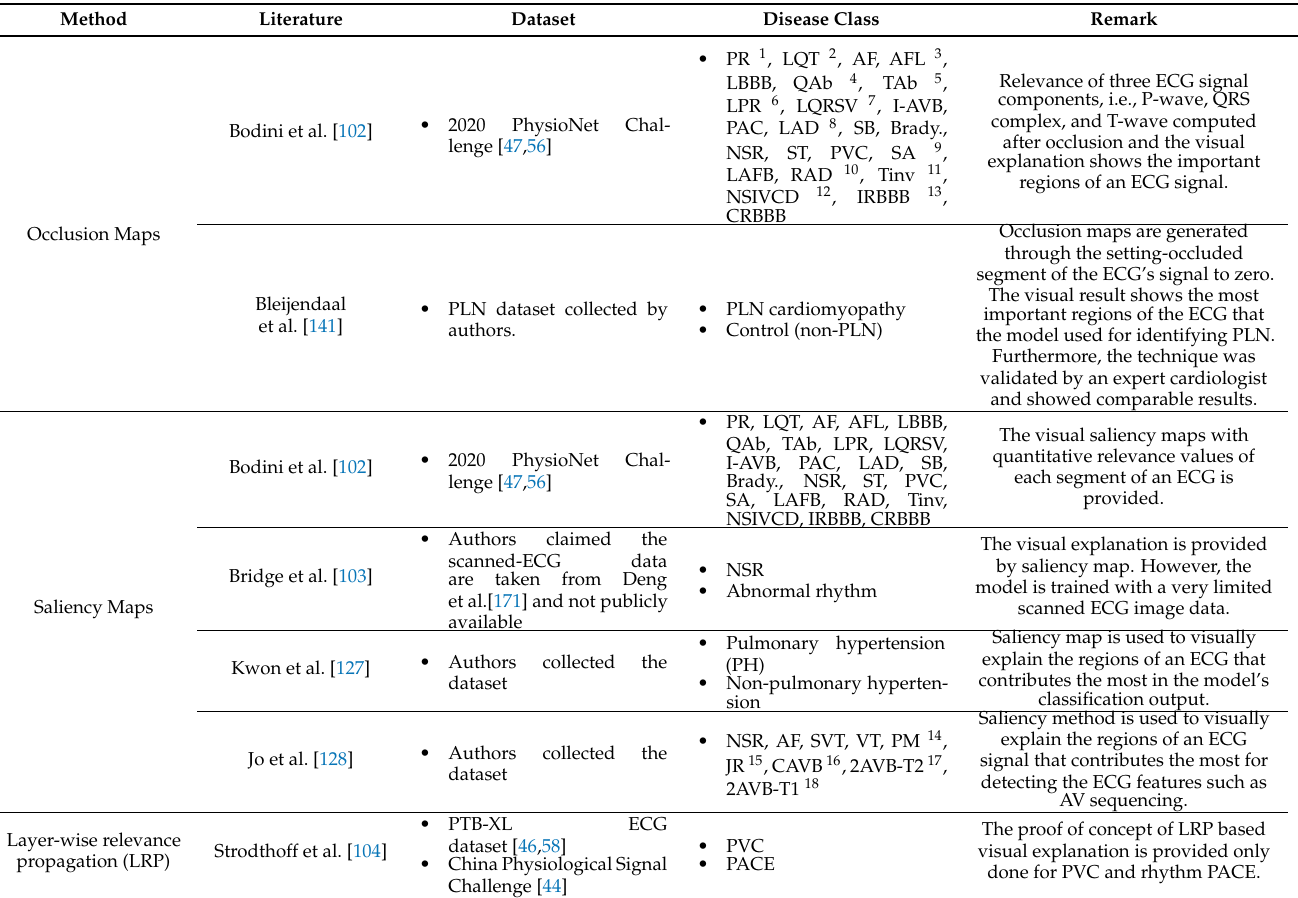
Table 9. Occlusion Maps, Saliency Maps, and LRP based Visual observation based IML techniques performance